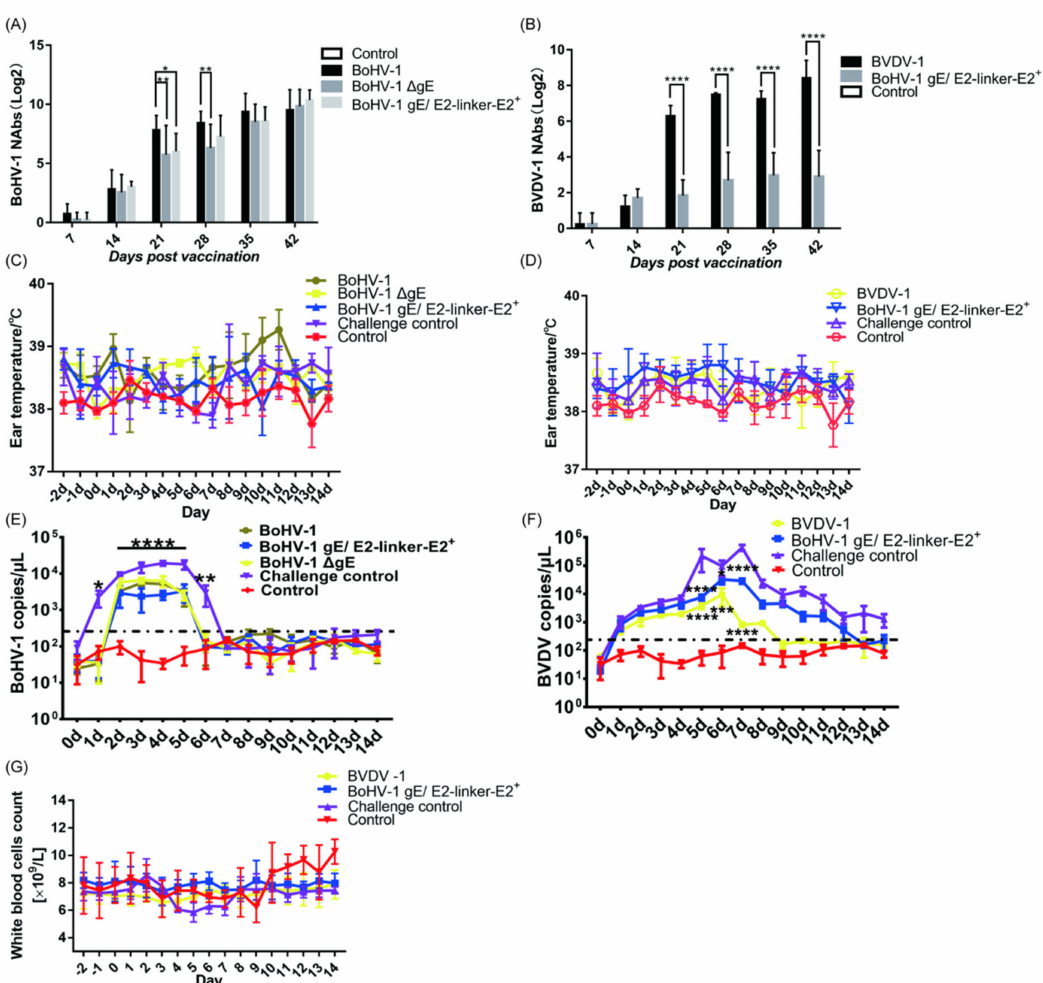
Figure 3. Immunogenicity and protective experiments of BoHV − 1 gE/E2 − Linker − E2 + and BoHV − 1 ∆ gE on guinea pigs. Immunogenicity experiment: intramuscular immunization of inactivated antigen, second immunization 21 days after the first immunization. Serum samples were collected to detect specific neutralizing antibodies 7 days after the initial immunization until day 42. ( A ) BoHV − 1 specific neutralizing antibody. ( B ) BVDV − 1 specific neutralizing antibody. Protective experiment: